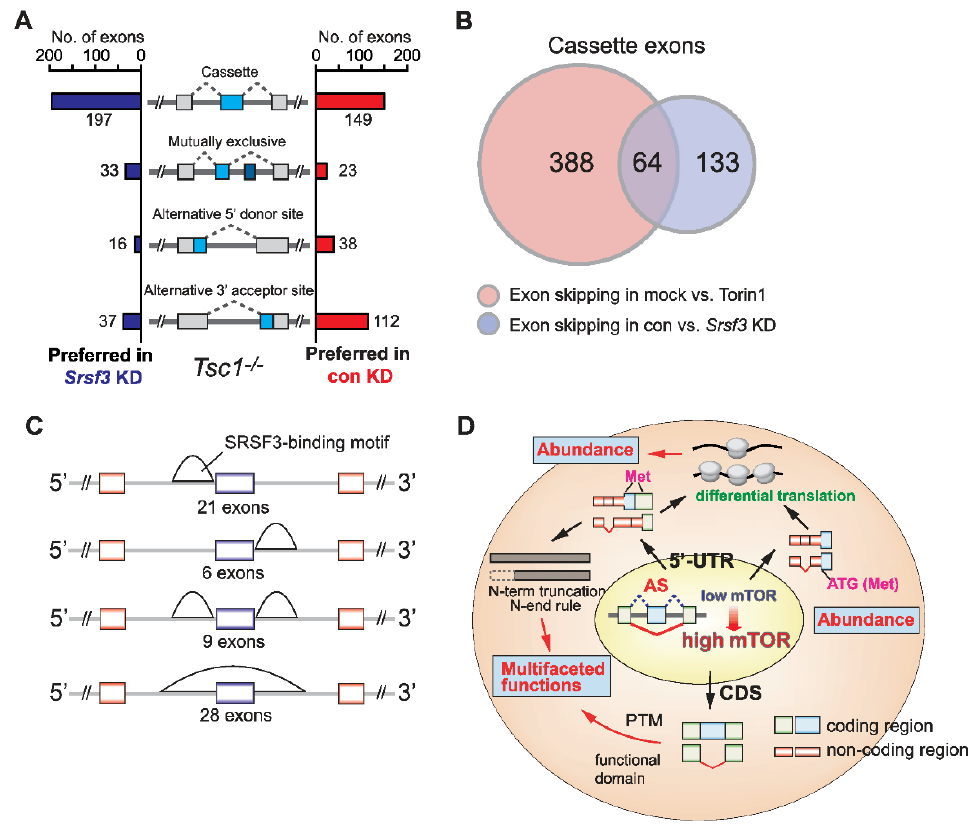
Figure 5. SRSF3 suppresses exon inclusion in mTOR-activated cells. ( A ) Analyses of four different types of alternative splicing events in control vs. Srsf3 knockdown in Tsc1-/- MEFs. Cases of alternative exon inclusion are compared and illustrated. ( B ) Venn diagram illustrating the overlap of skipped exons in mock vs. Torin 1 in Tsc1-/- MEFs and control vs. Srsf3 knockdown in Tsc1-/- MEFs datasets. ( C ) In silico prediction of SRSF3 putative binding sites using the overlapped exons as reported in panel B. The putative sites were determined using RBPMap [58]. ( D ) Summary model of mTOR-mediated AS and the impact on the functional proteome.